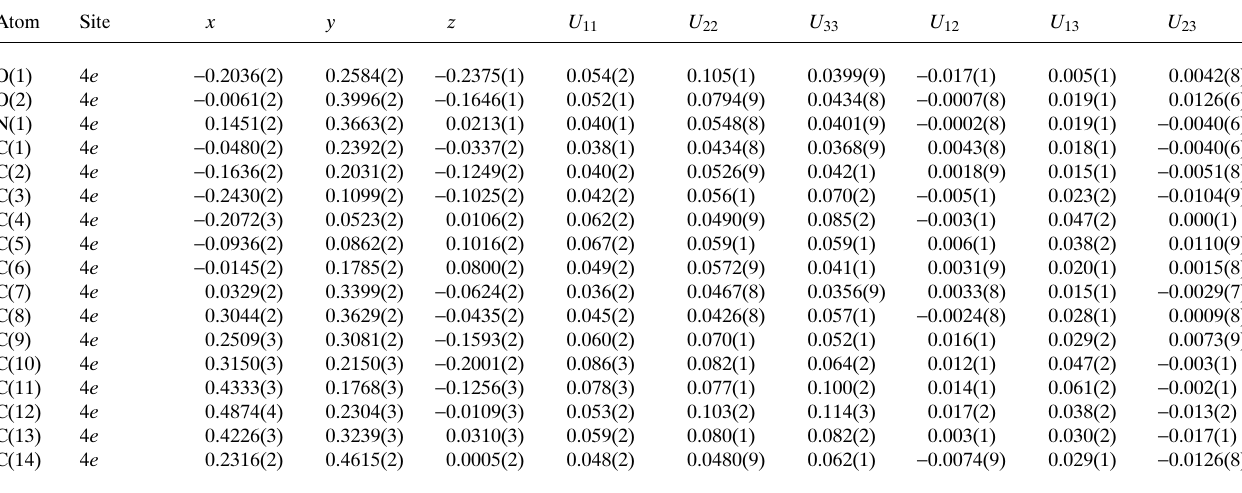
Table 3. Atomic coordinates and displacement parameters (in Å 2 )